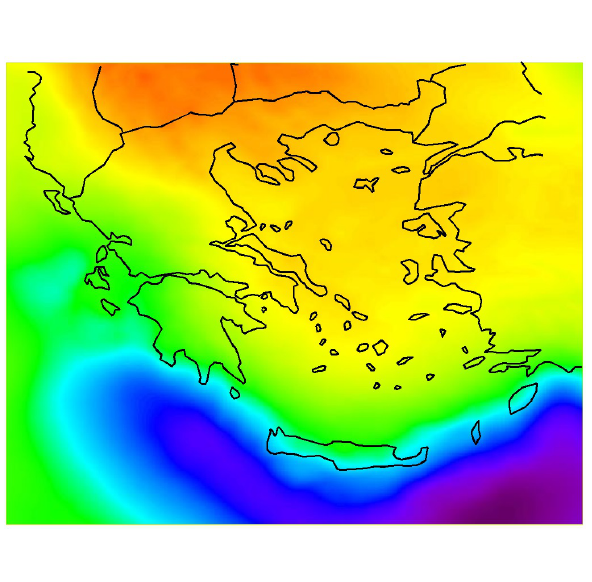
Figure 3: Geoid undulation over the country according to EGM2008.